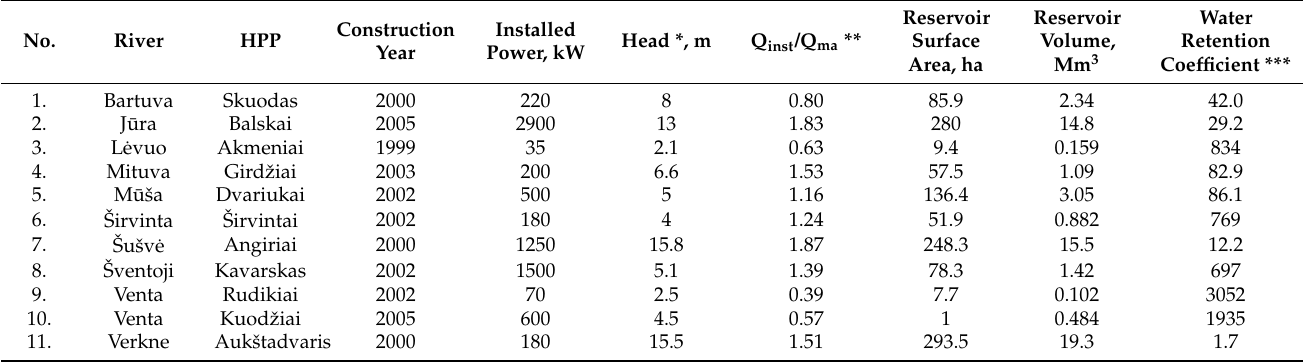
Table 1. Characteristics of the investigated hydropower plants.